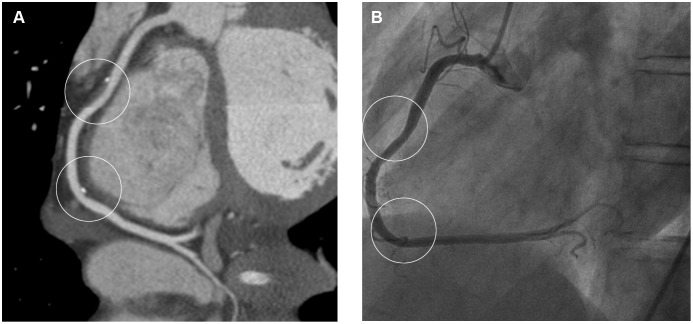
The right coronary artery in a patient presenting with acute myocardial infarction.Cardiac computed tomography (A) shows a large atherosclerotic plaque and more distally a small plaque, both with <20% stenosis. Coronary angiography (B) shows only minimal signs of atherosclerosis.